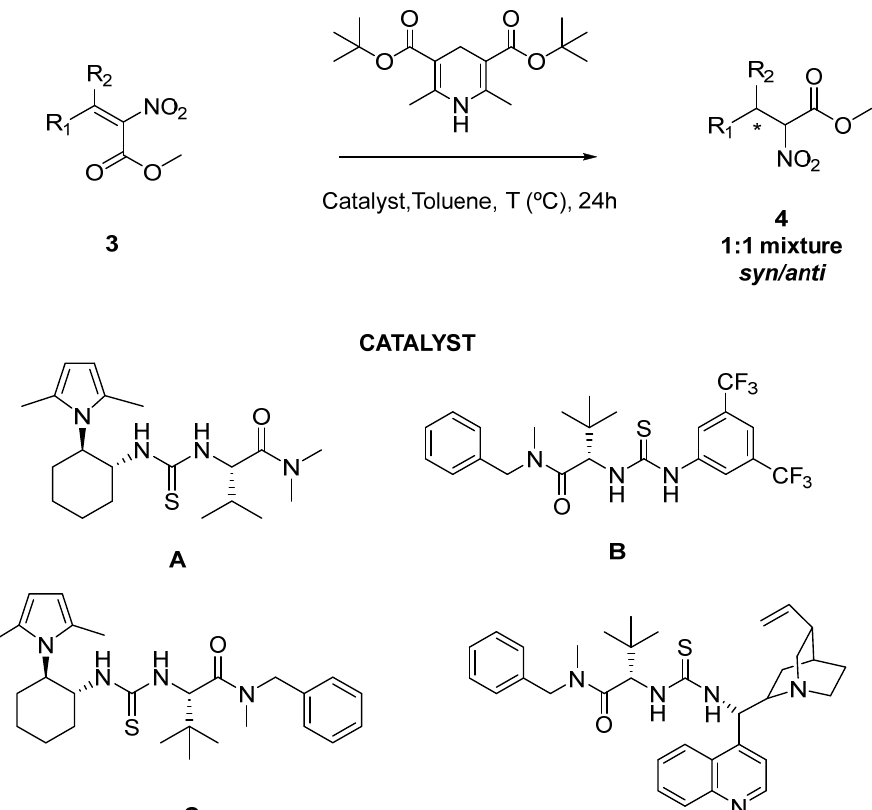
Table 3. Enantioselective reduction of tetrasubstituted nitroalkenes